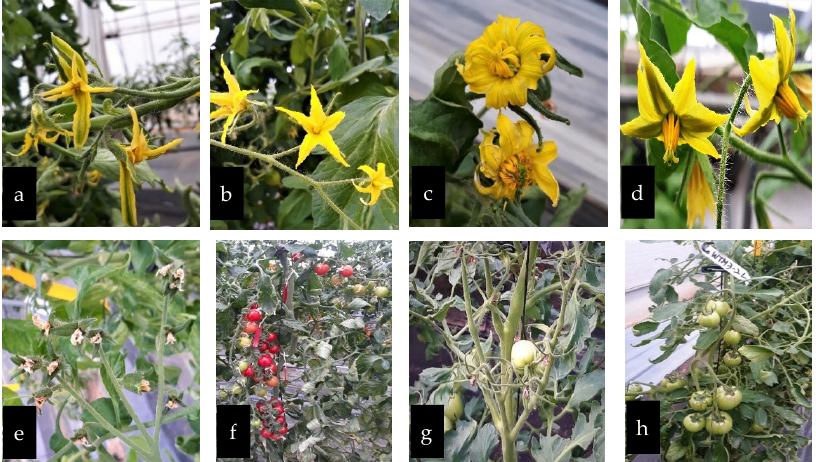
Figure 5. Different responses to low night temperature between tolerant and sensitive accessions in the development of tomato flowers and fruits. Abnormal ( a ) and normal flowers ( b ) of T7SS and T14ST, respectively; abnormal ( c ) and normal ( d ) flowers of T24LS andT27LT, respectively; no fruit set ( e ) and fruits ( f ) of T7SS and T14ST, respectively; small fruit set ( g ) and fruits ( h ) of T24LS and T27LT, respectively. All plants were grown in the night temperature of 10 °C.